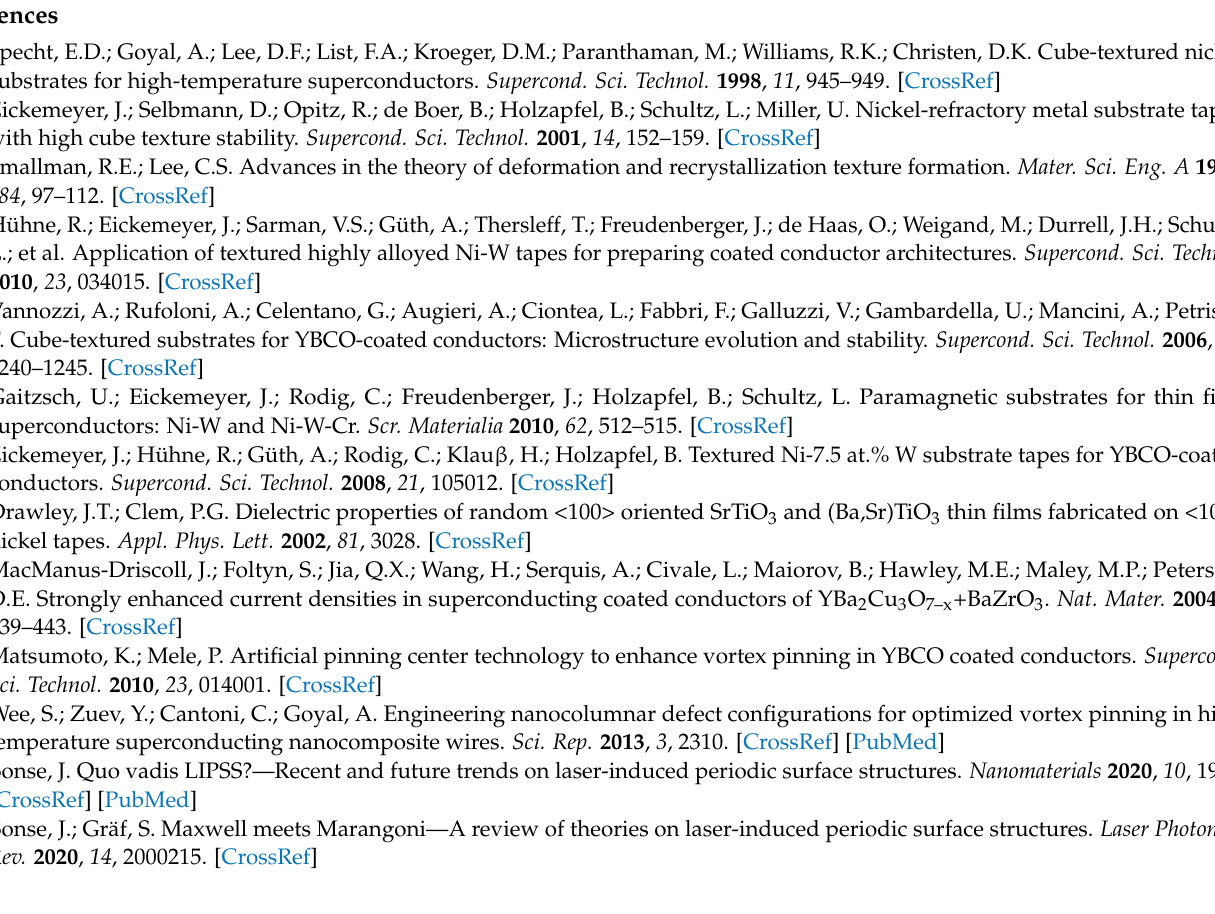
Figure S3. Scheme of the crystallographic projections used to build Figure 11. RD and TD define the plane of the tape surface, ND is the normal